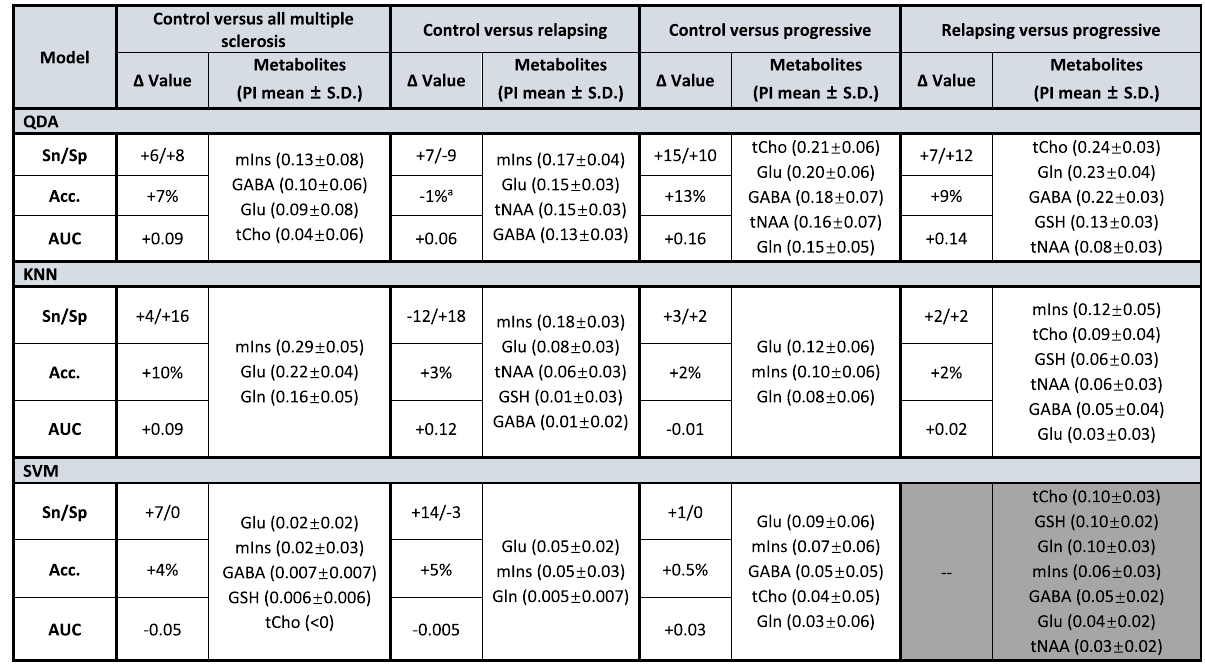
Table 3. Effect of metabolite selection on binary classifier leave-one-out cross-validation (LOOCV) performance. Grey indicates no feature selection implemented due to resultant reductions in model cross validation accuracy. a Feature elimination performed in this algorithm despite no substantial improvement in CV accuracy due to appreciable increase in AUROC. PI permutation importance, S.D . standard deviation, Sn sensitivity, Sp specificity, Acc. Accuracy, AUC area under receiver operating characteristic (ROC) or